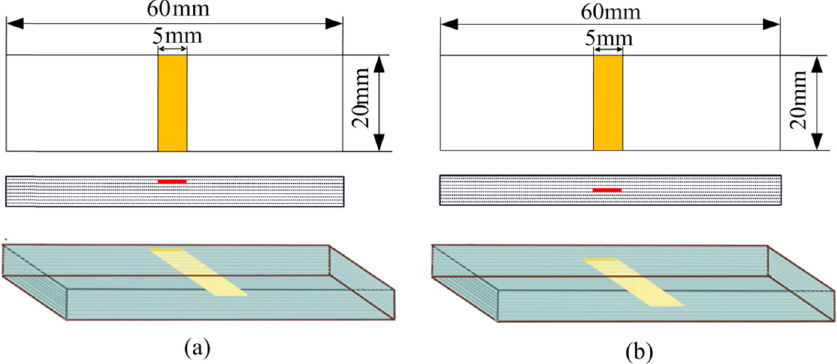
Figure 2: Morphological characteristics of the specimens: prefabricated delamination defects between layers ( a ) 2 and 3 and ( b ) 5 and